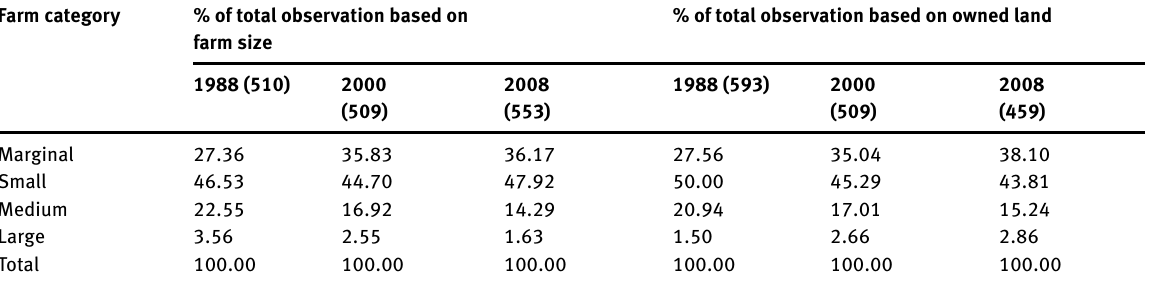
Table 2: Proportion of farm households in different farm categories based on owned and cultivated land per